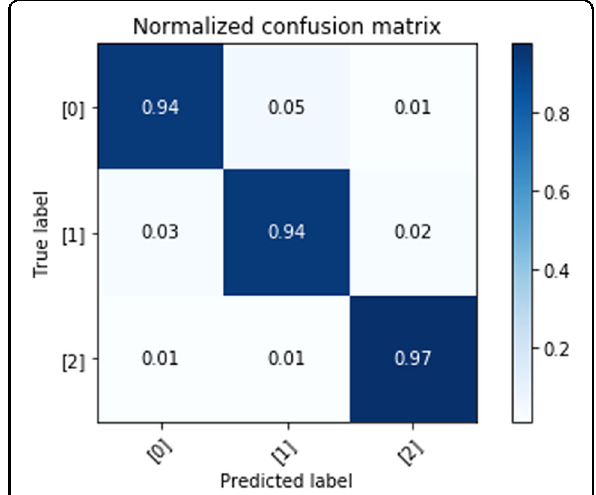
Fig. 5 Normalized confusion matrix for WEMWBS evaluation utilizing visual metrics and CNN-LSTM algorithm. Element value (m, n) of this matrix, and color, represent the probability of predicted WEMWBS level n, given the ground-truthWEMWBS level m, where m and n have labels of 0 (low), 1(intermediate/controllable), and 2 (high). The diagonal elements of this matrix correspond to correct